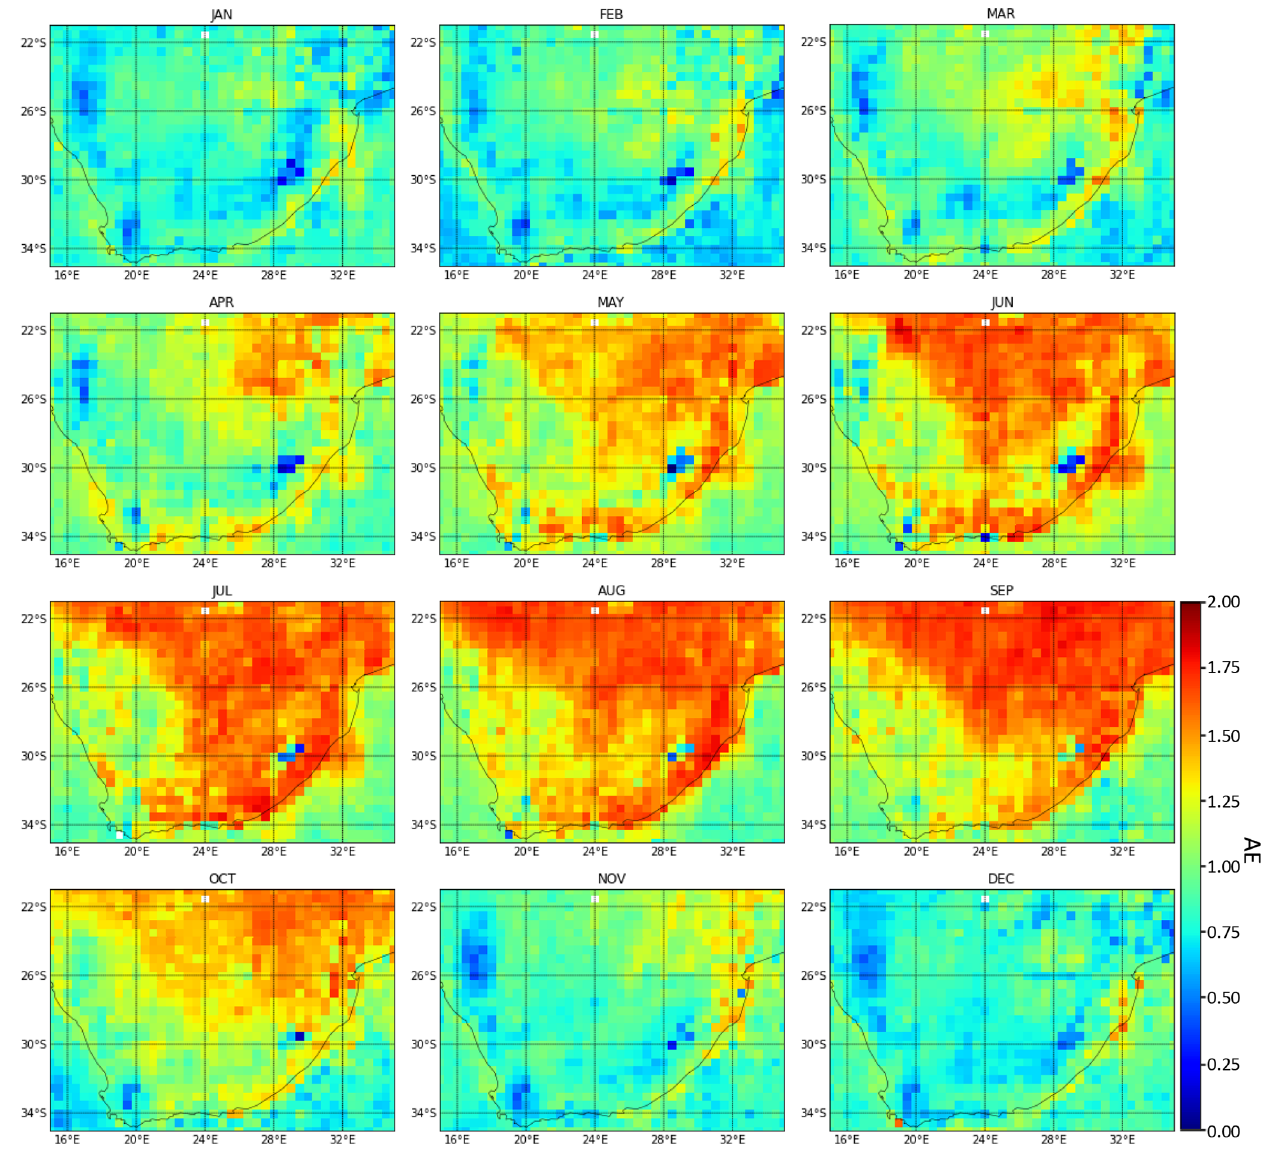
Figure 4. Average Ångström exponent (AE) over South Africa from MISR data for 10